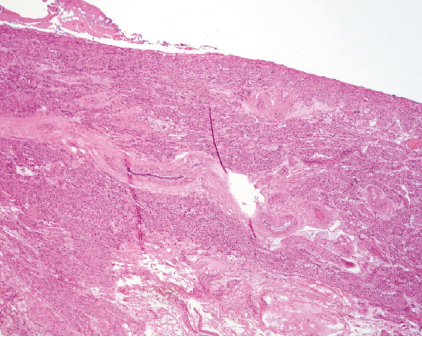
Figure 1: Pathology of the right and left ovaries shows hypoplastic ovarian tissue with fibrotic stroma and an absence of follicles.